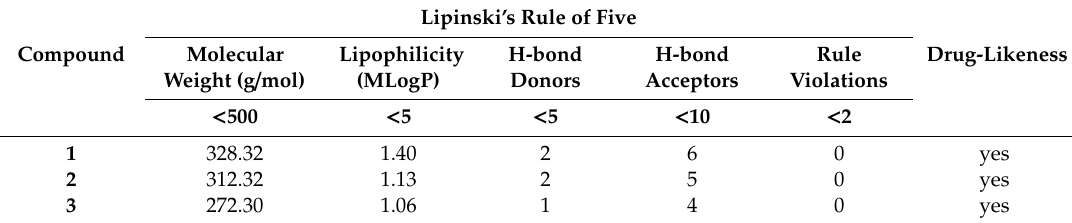
Table 2. Lipinski’s Rule of Five for absorption, distribution, metabolism, and excretion (ADME) analysis of isolated